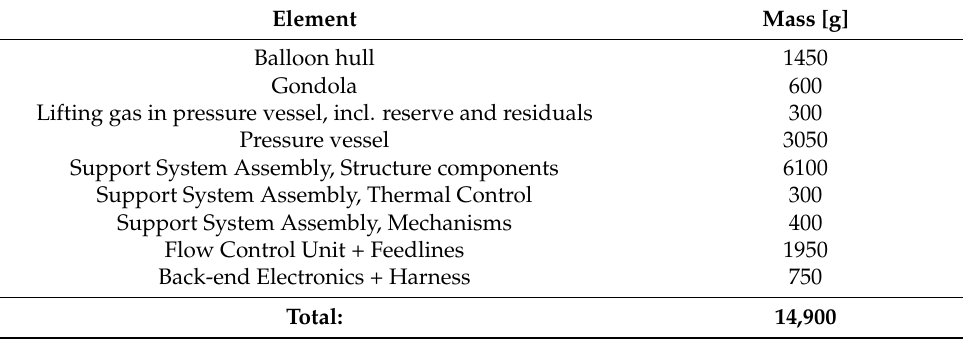
Table 1. Mass break-down table, component masses include maturity margins and are rounded up to next 50 g level.